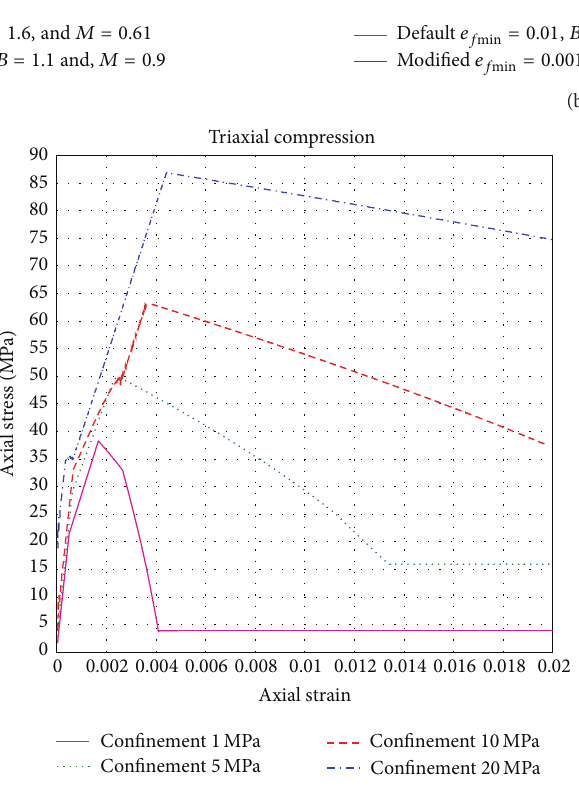
Engineered Cementitious Composites (ECC) from the top to bottom. Each slab is subjected to one blast detonation. A bomb equivalent to 7.3 kg TNT charge is placed with its center of gravity about 170 mm above the center of the slab surface. These two samples are cast at site with the dimension of 2.8 m in both length and width and 0.275 m in